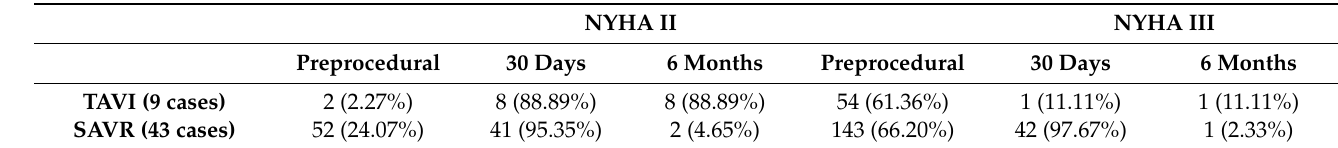
Table 4. Heart failure evolution.